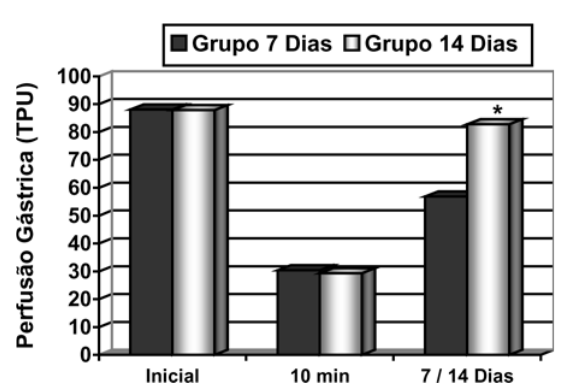
FIGURA 4 – Fluxometria (expressa em Unidade de Perfusão Tecidual) da região proximal do estômago nos diferentes períodos de observação.